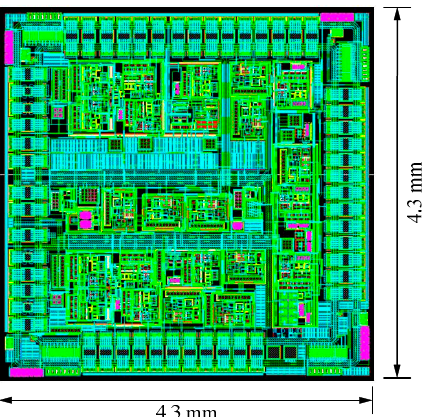
Figure 9. Layout of the interface circuit for micro gyroscope with ball-disc rotor.